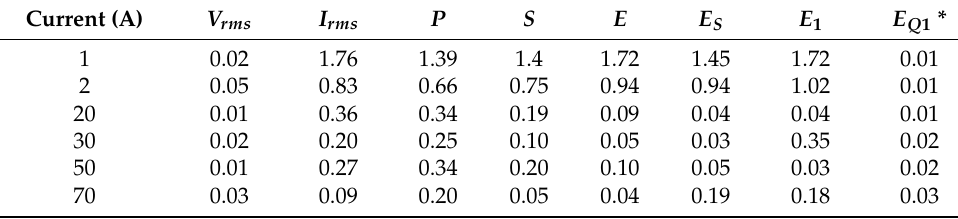
Table A2. “Harm Q” test results.